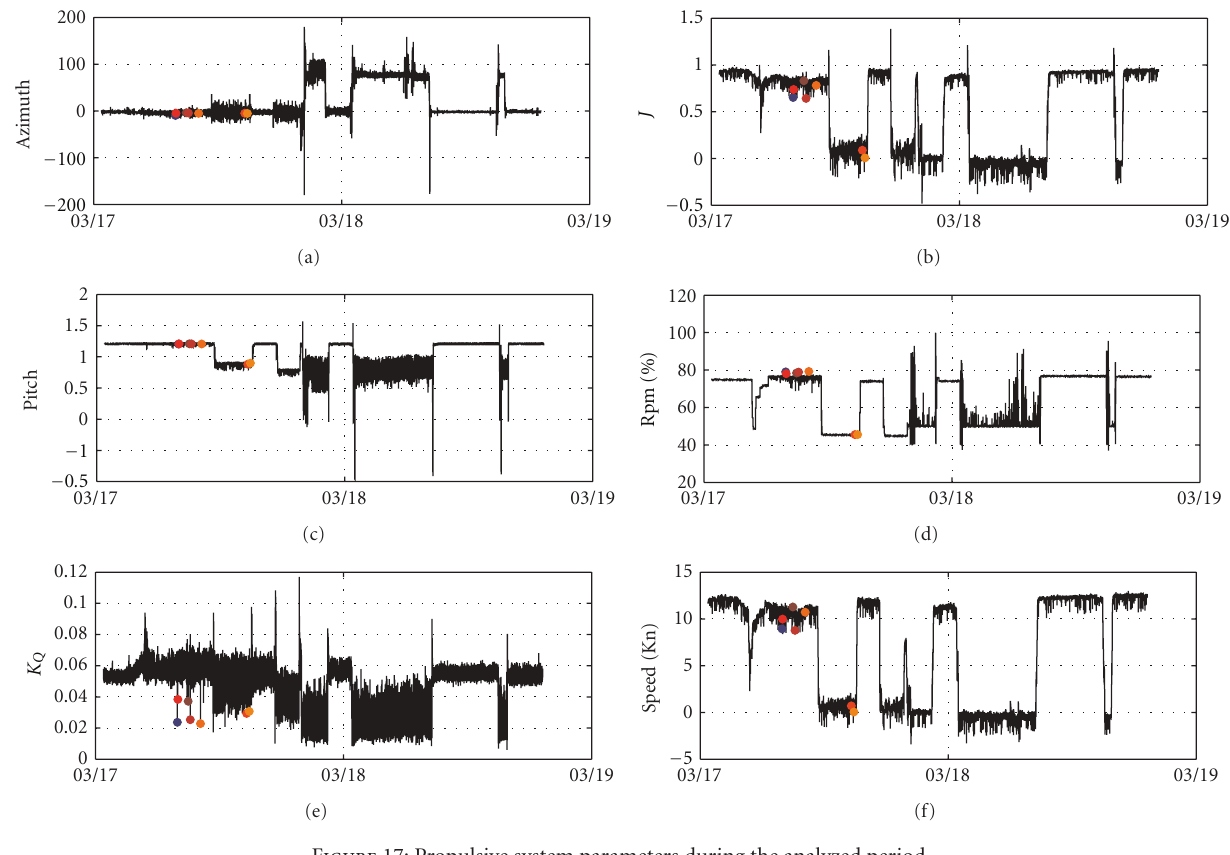
Figure 17: Propulsive system parameters during the analyzed period.